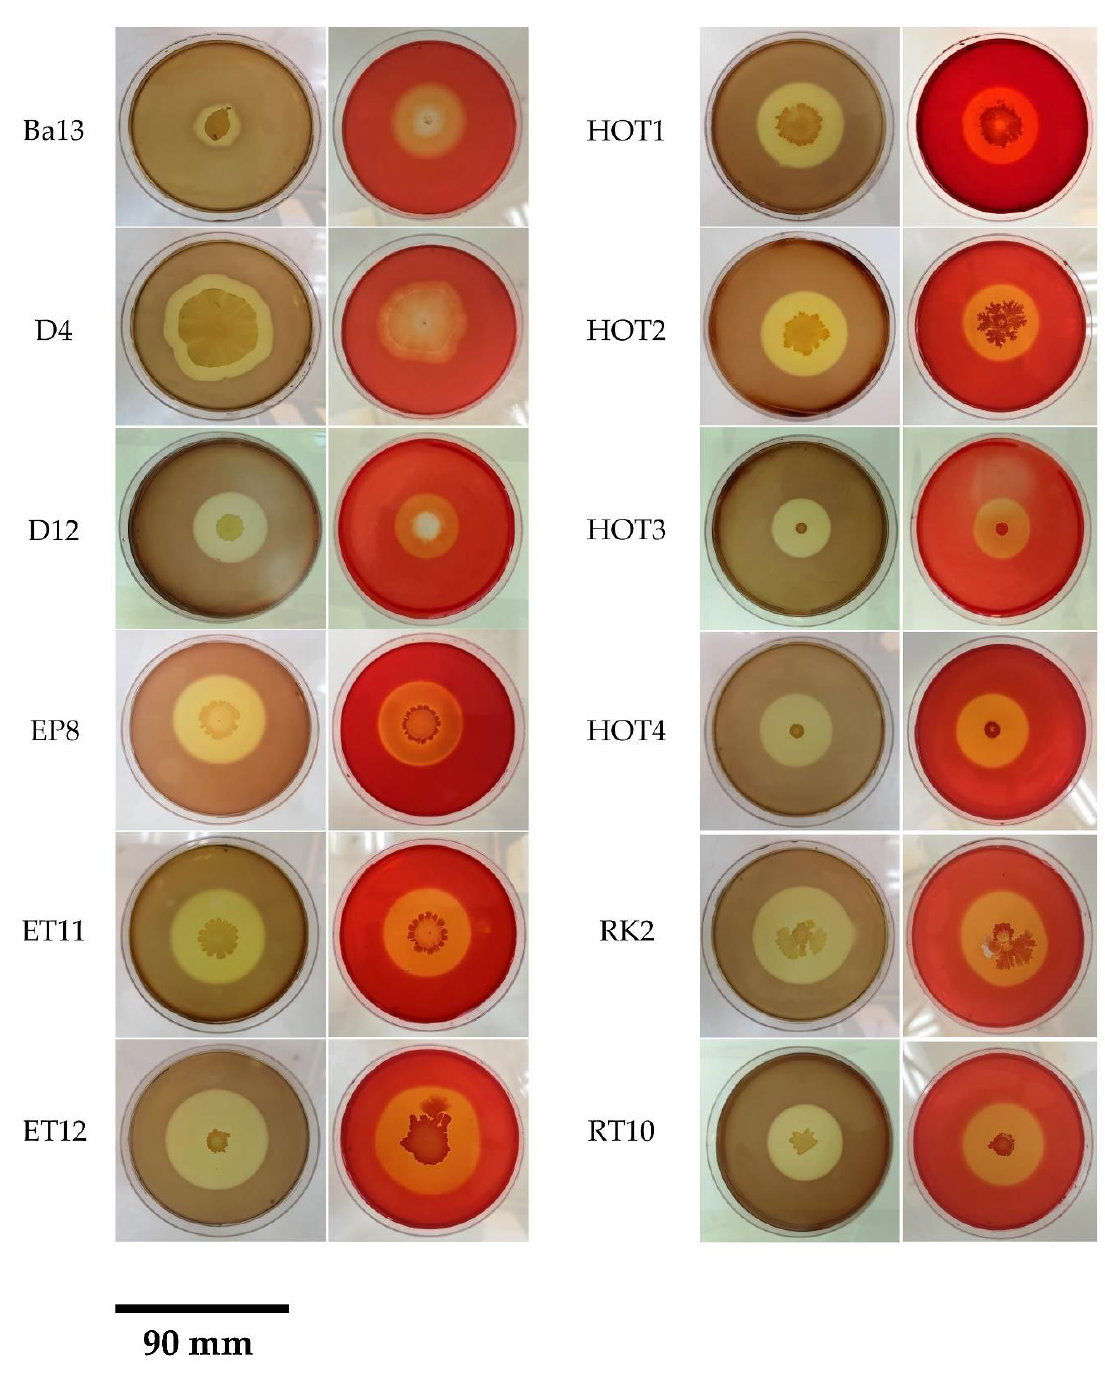
Figure 2. Illustration of CMC hydrolysis zones by the tested isolates (Ba13, D4, D12, EP8, ET11, ET12, HOT1, HOT2, HOT3, HOT4, RK2, and RT10) revealed by Congo red and Lugol solutions.